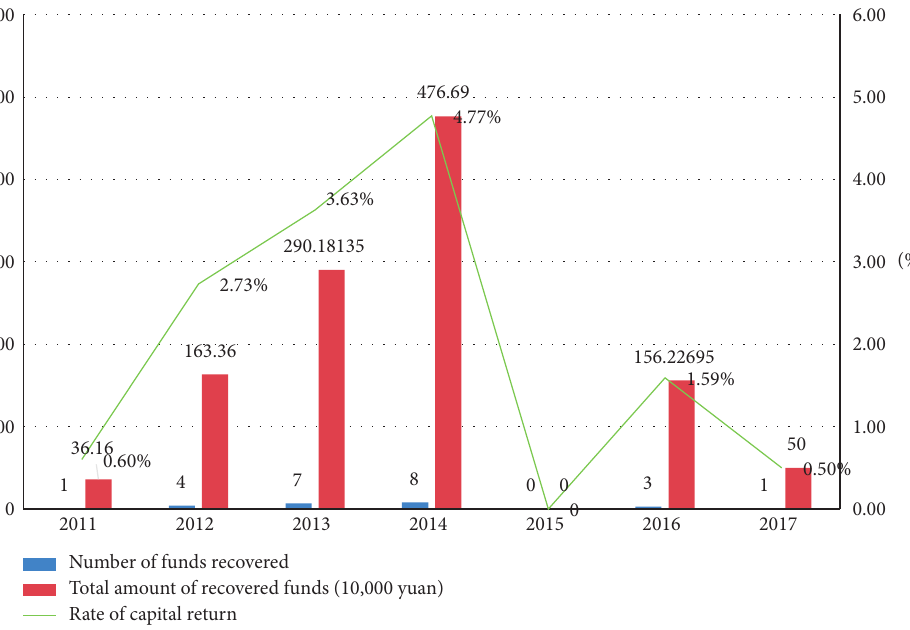
Figure 7: Project fund recovery rate from 2011 to 2017.